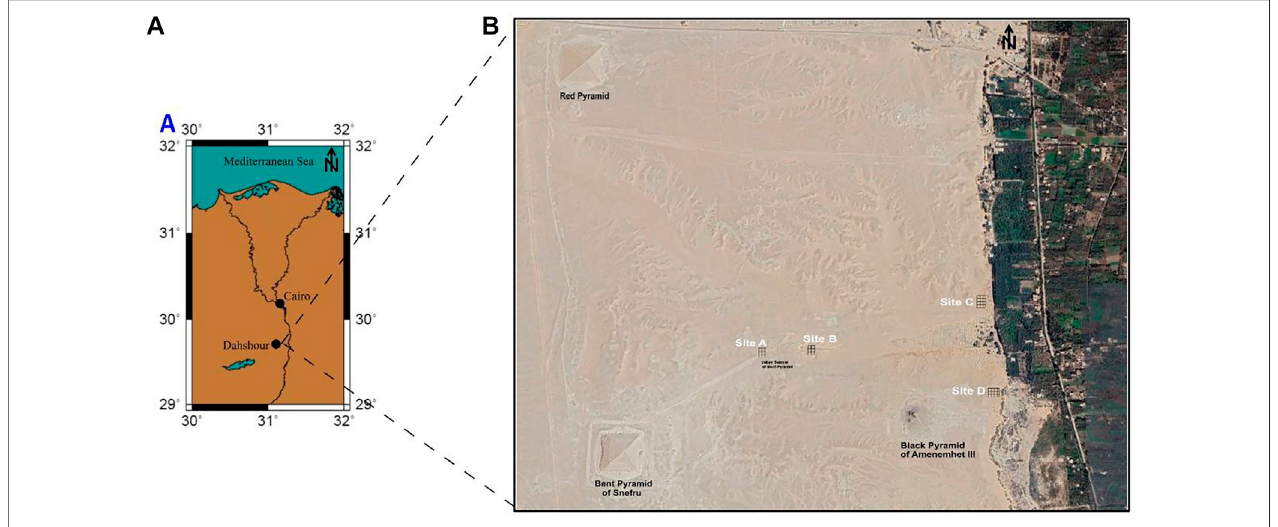
FIGURE 1 | (A) Map of Egypt showing the location of Dahshour area. (B) Satellite image showing the study areas as represented by sites (A, B, C, and D) (reproduced from Google Earth).